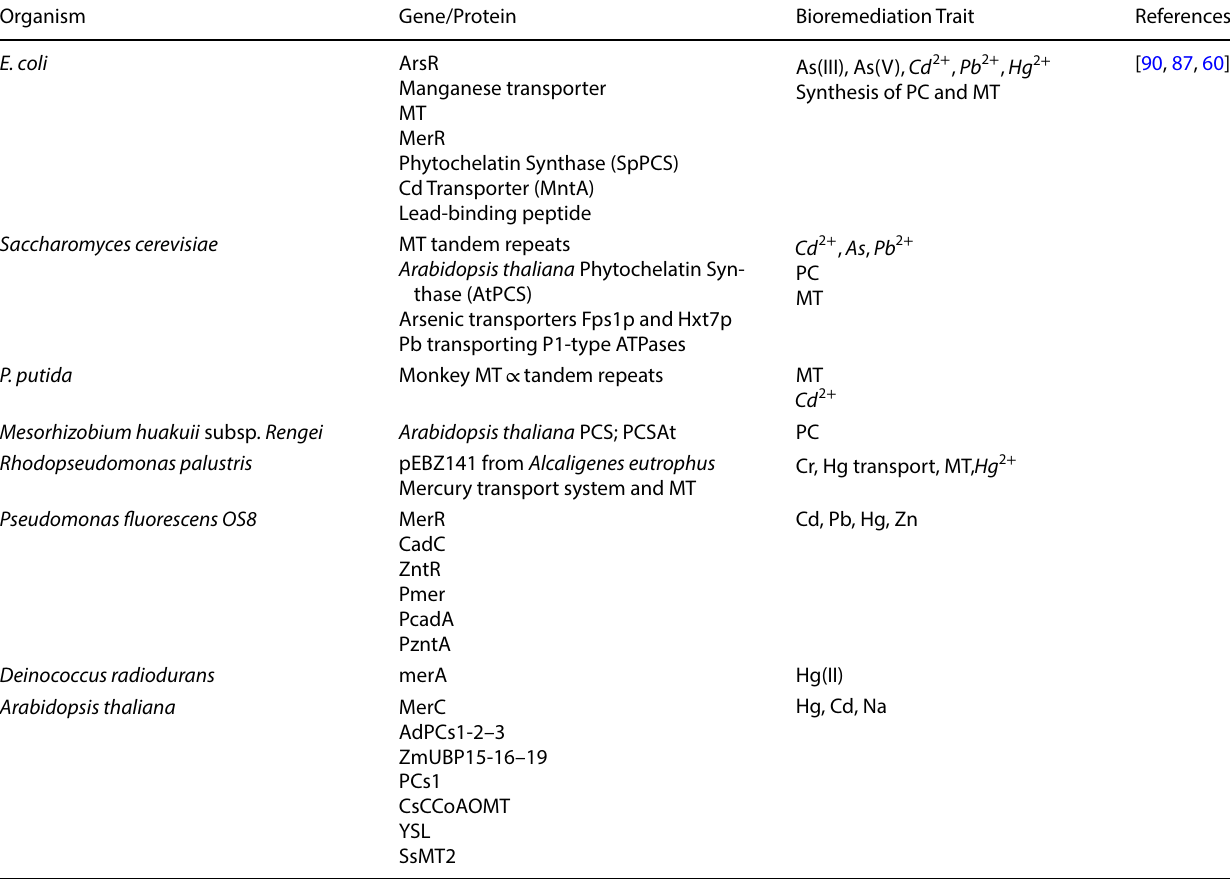
Table 7 Examples of genetically engineered organisms with heavy metal remediation characteristics in modern times